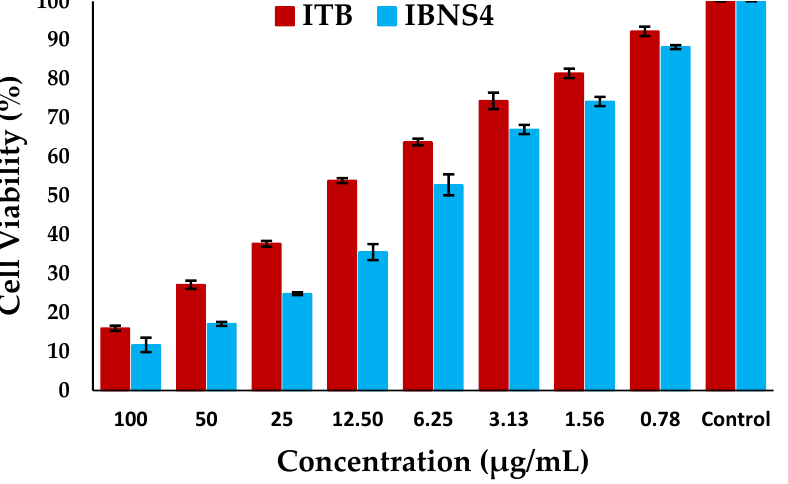
Figure 8. Cytotoxicity of pure Ibrutinib (ITB) and optimized ibrutinib-loaded nanosponges (IBNS4) after 48 h of incubation with MCF-7 cells at different concentrations (0.78–100 μg/mL) and control.